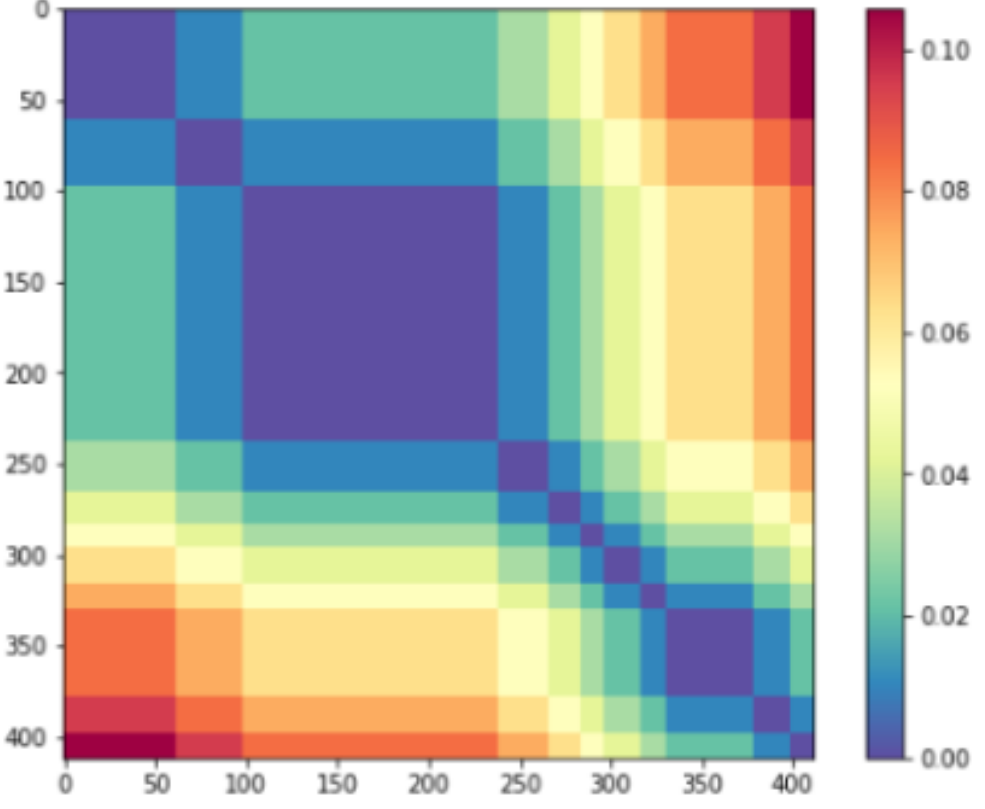
Figure 6. Model representational dissimilarity matrix for 412 test sentence pairs measured by distance between ground-truth semantic similarity scores. The dimensions of the dissimilarity matrix are sorted by each sentence-pair’s ground-truth semantic similarity